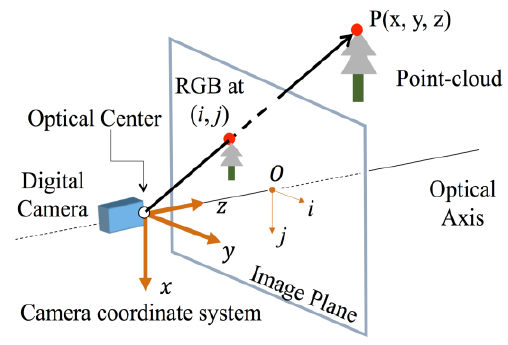
Figure 2. Pinhole camera model